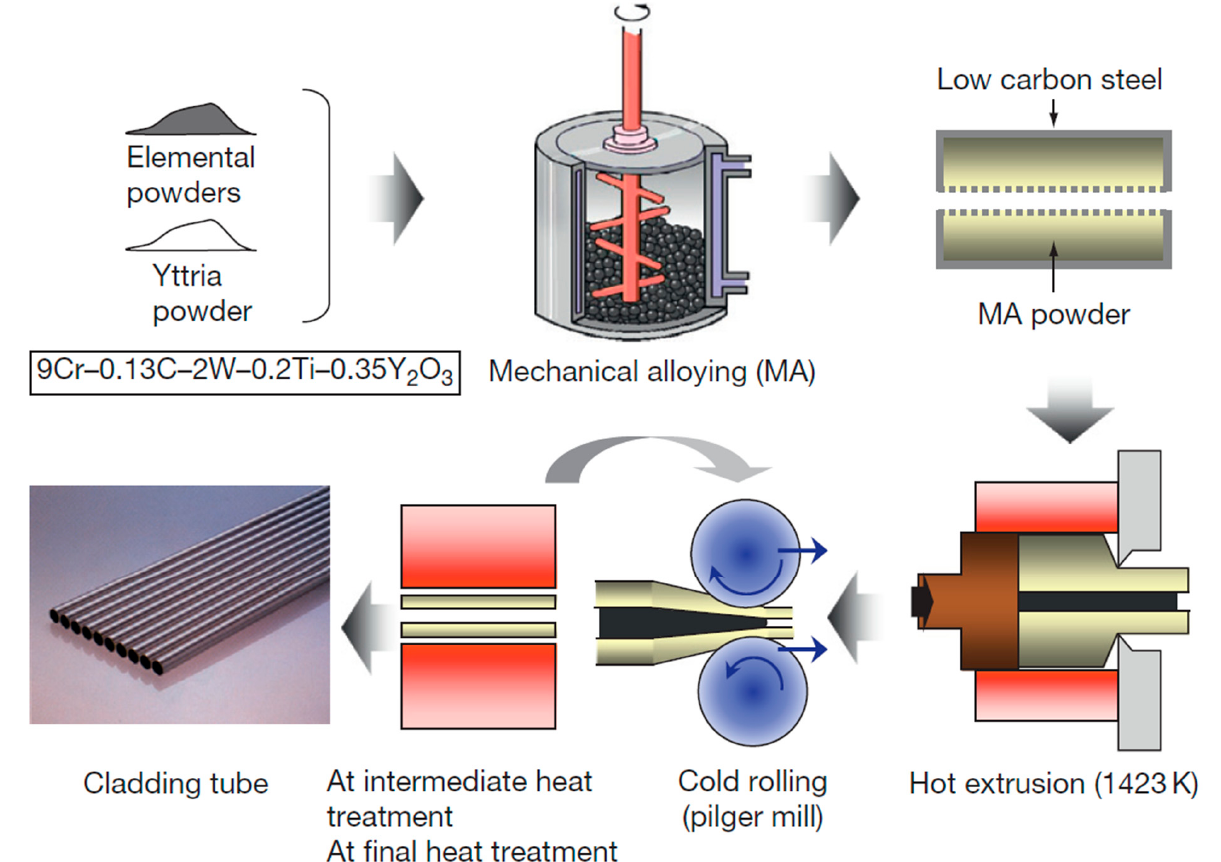
Figure 5. Schematic of powder metallurgy by mechanical alloying manufacturing processes of cladding tube reprinted with permission from ref. [115], 2022, Elsevier.